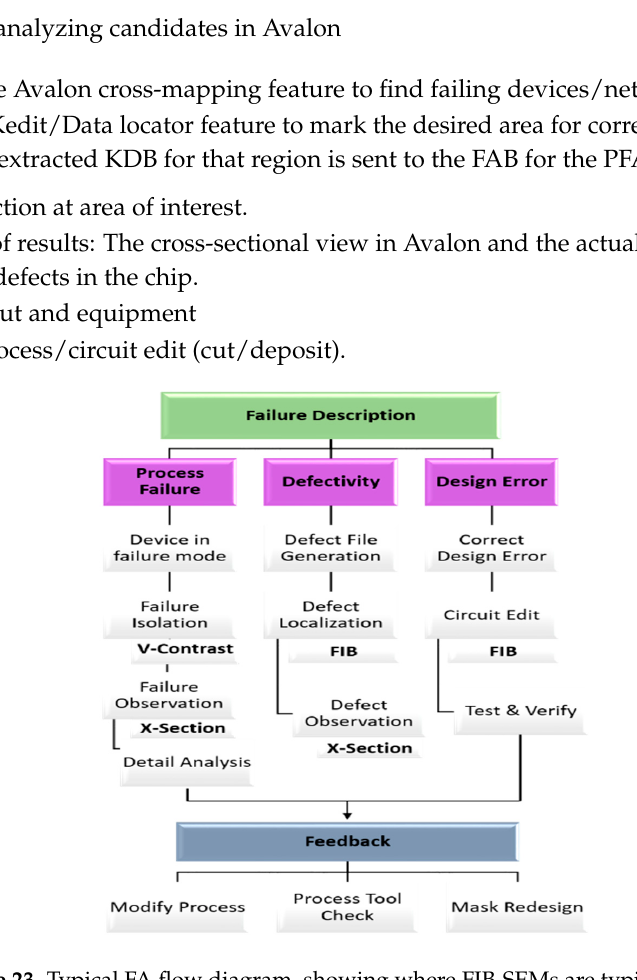
Figure 23. Typical FA flow diagram, showing where FIB-SEMs are typically used.